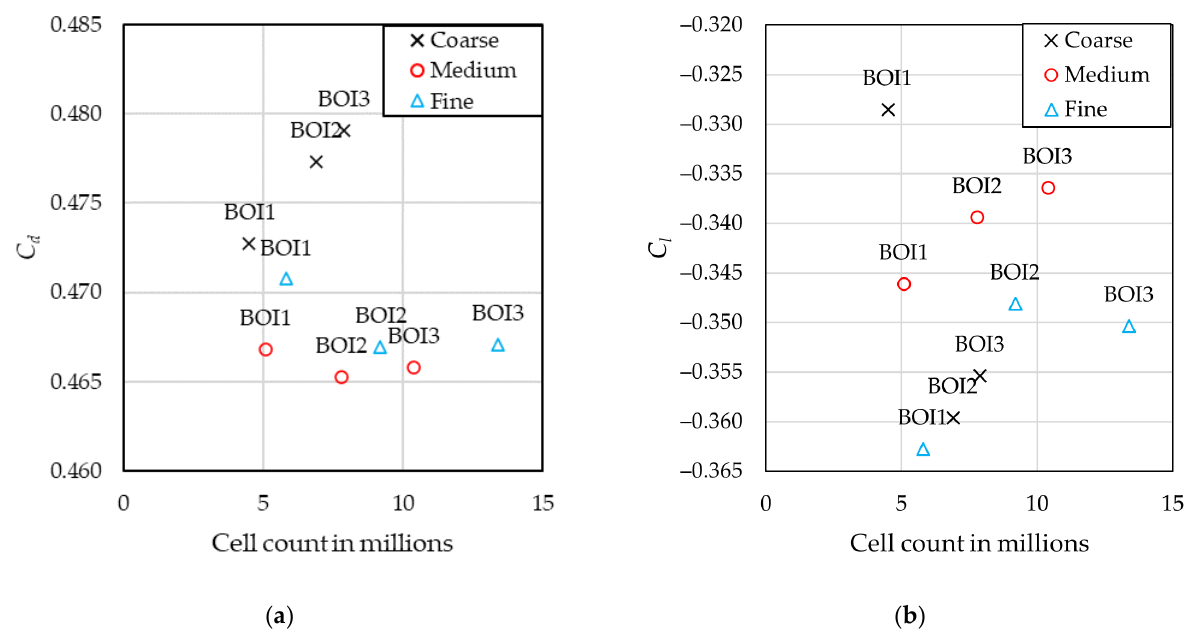
Figure 10. Grid convergence test results: ( a ) drag coefficient; ( b ) lift coefficient. Table 2. Grid convergence test results for medium-sized body of influence (BOI 2).